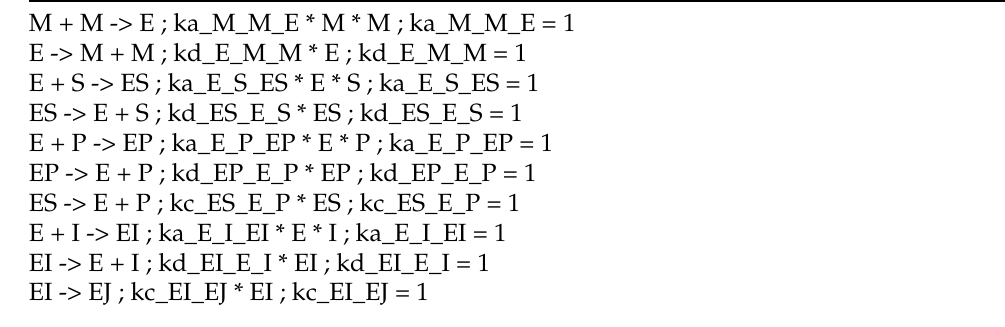
Scheme 2. The HIV model in Antimony language, created by KinModGPT with text-davinci-003 .